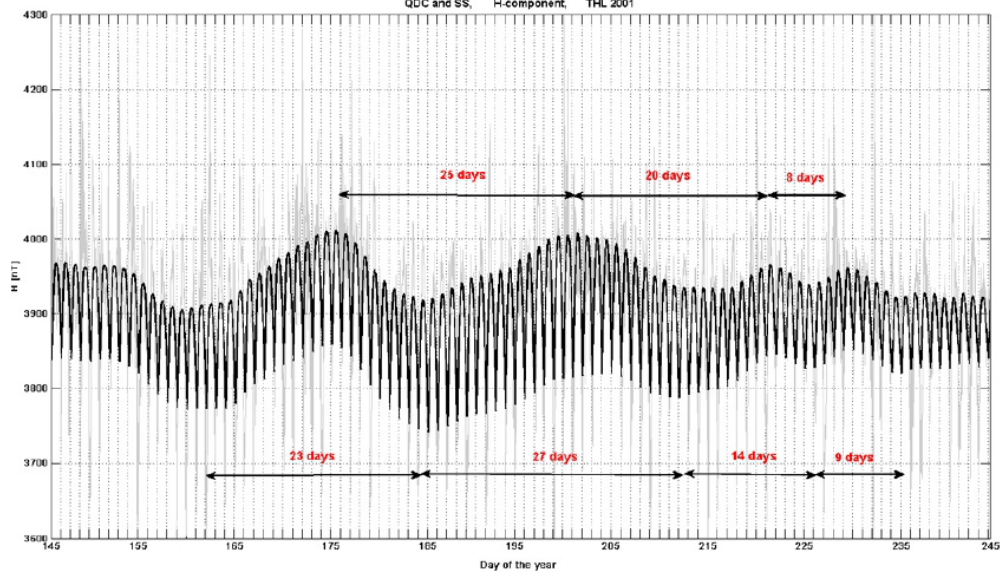
Fig. A1. Figure 1 of Janzhura and Troshichev (2011). Superposition of the actual variation of 1min values of the geomagnetic H component observed at Thule station in the summer season of 2001 (thin lines) and the quiet daily curve (QDC) characterizing the daily variation of the quiet geomagnetic field (thick solid lines).